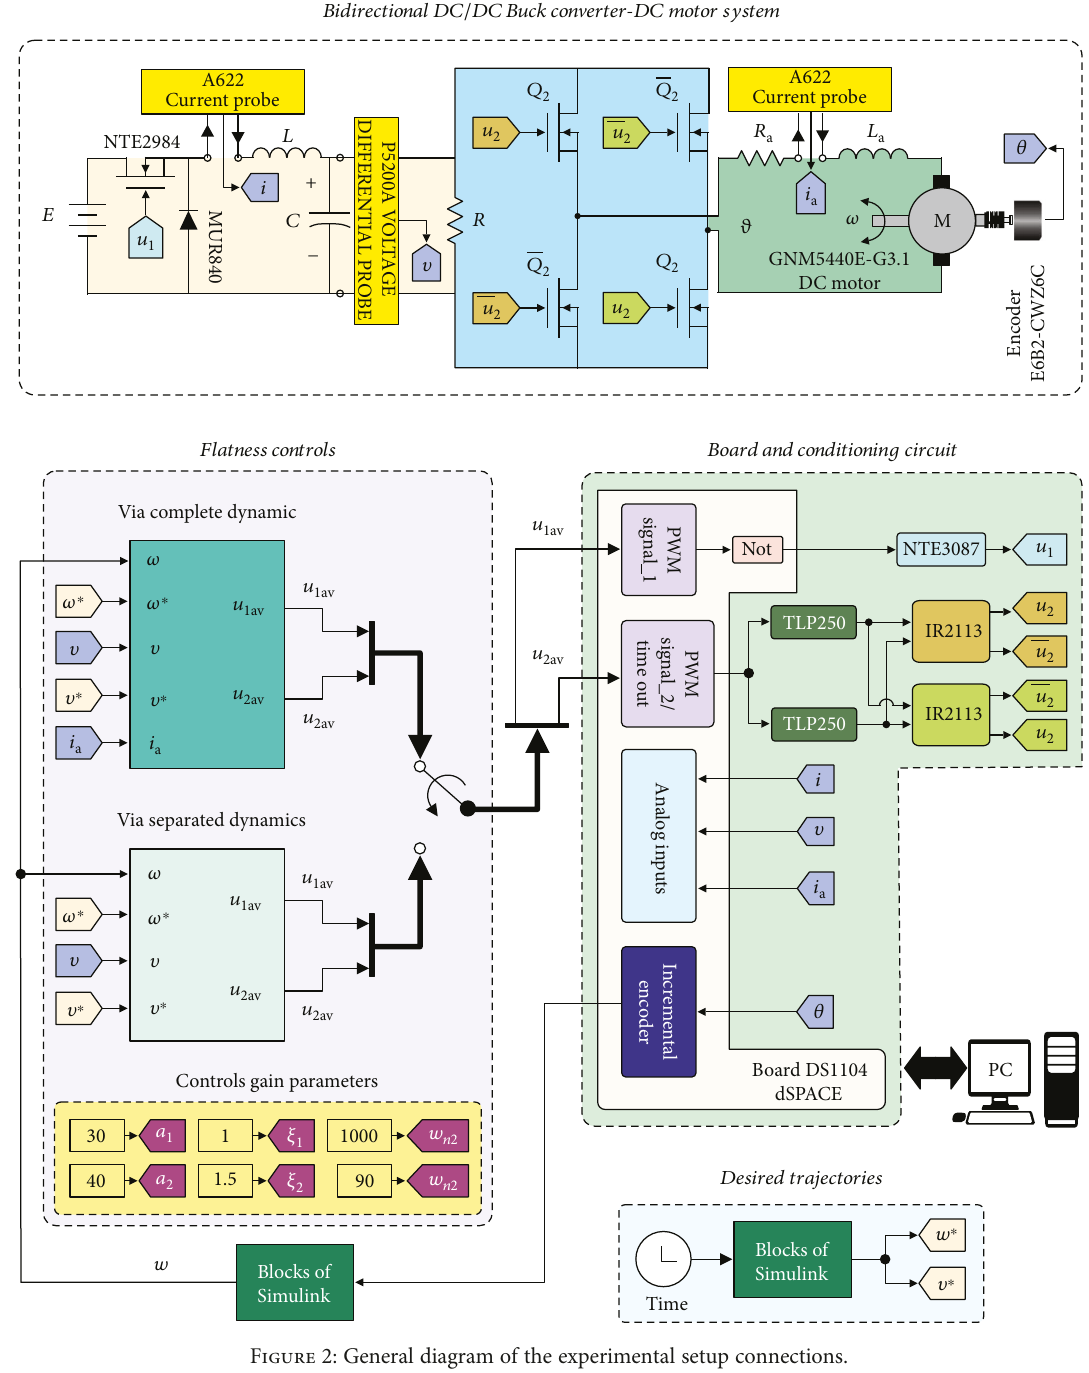
Figure 2: General diagram of the experimental setup